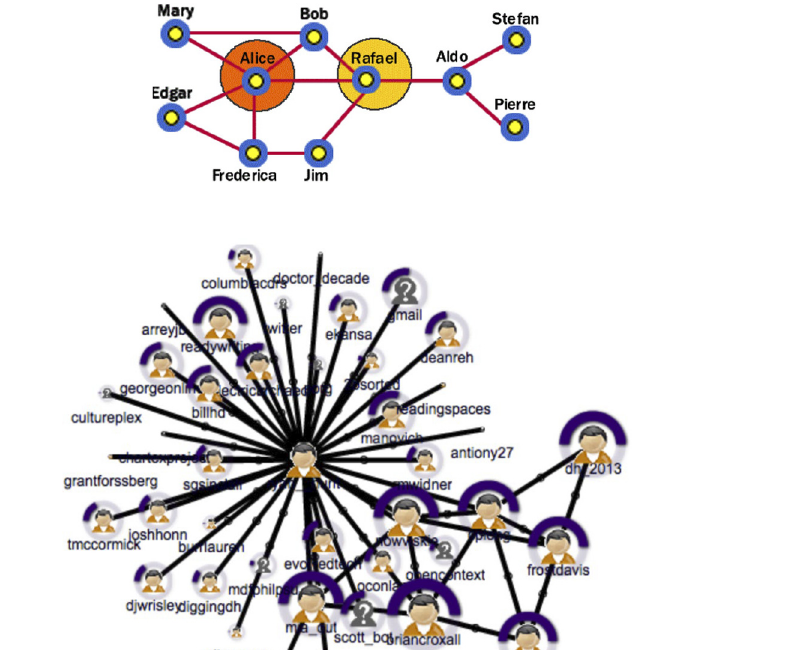
Figure 2. Network framework